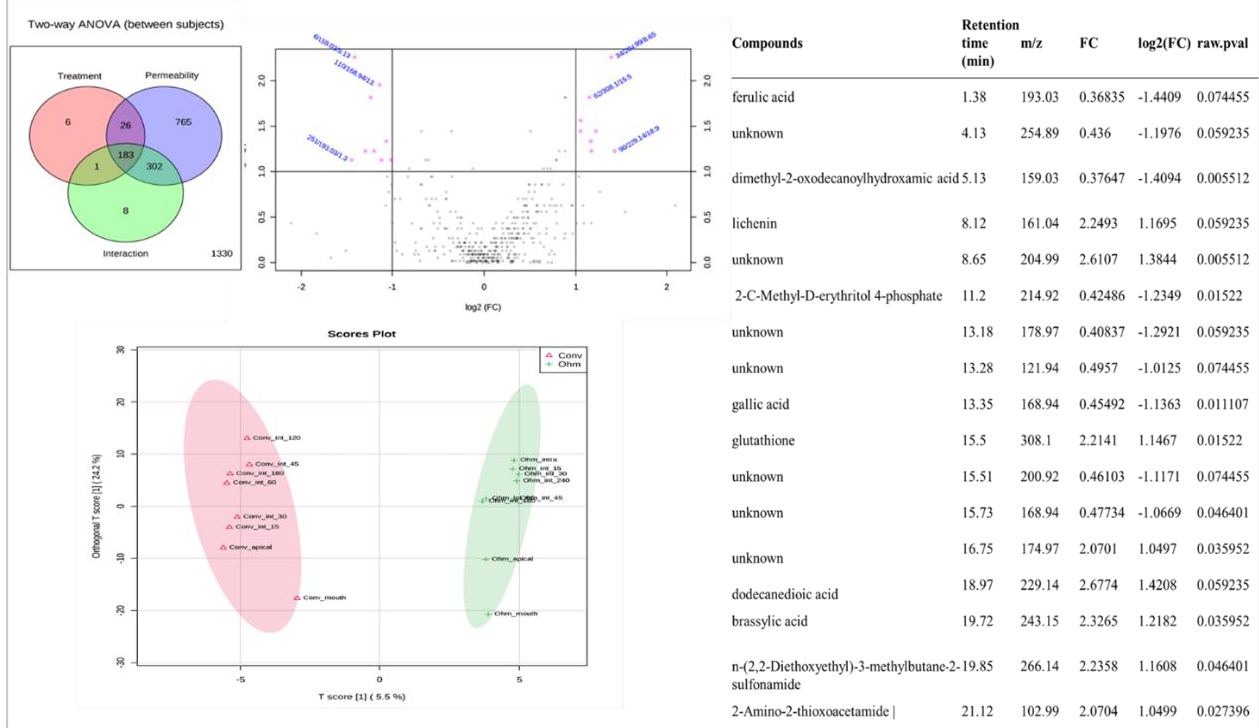
represent Figure 4. Cytotoxicity ( A ) and mutagenicity ( B ) of SFOH and SFCONV samples. In figure ( B ), rep-